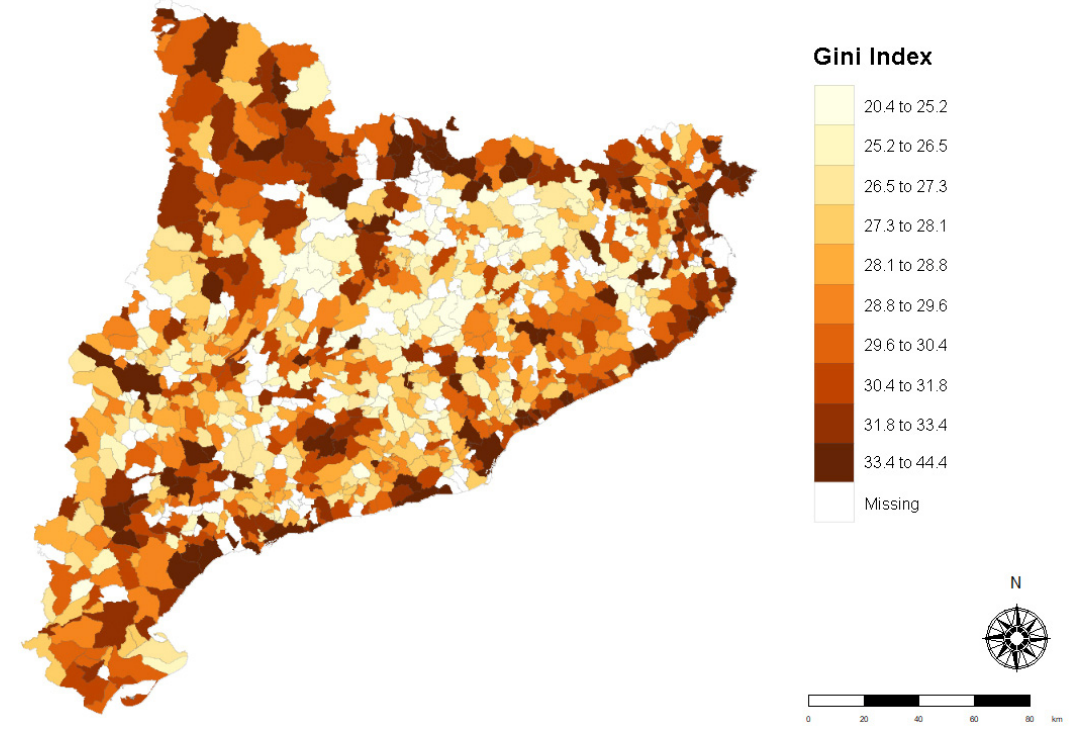
Figure 3. Map of the Gini index of Catalonia by municipalities.